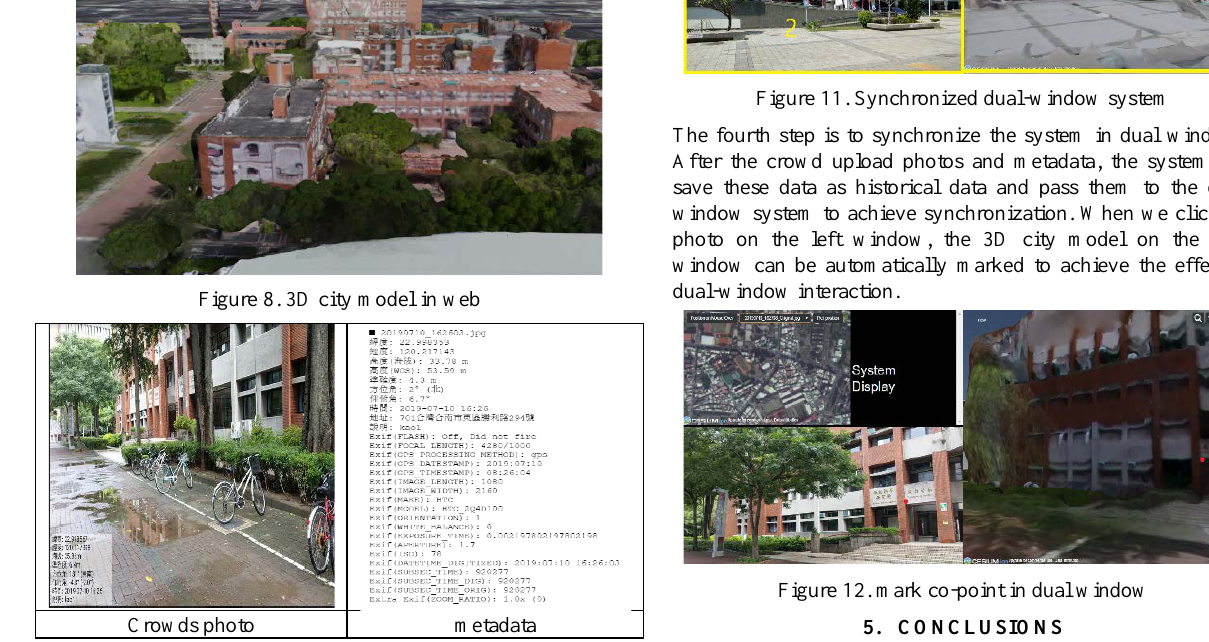
Figure 12. mark co-point in dual